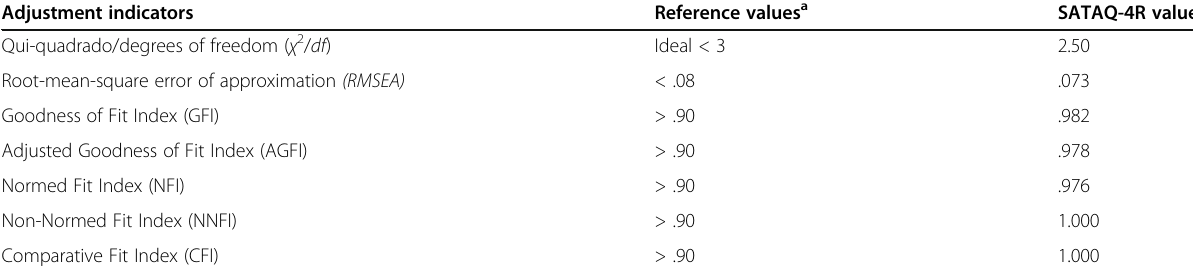
Table 3 Adjustment indicators of the SATAQ-4R for Brazilian girls